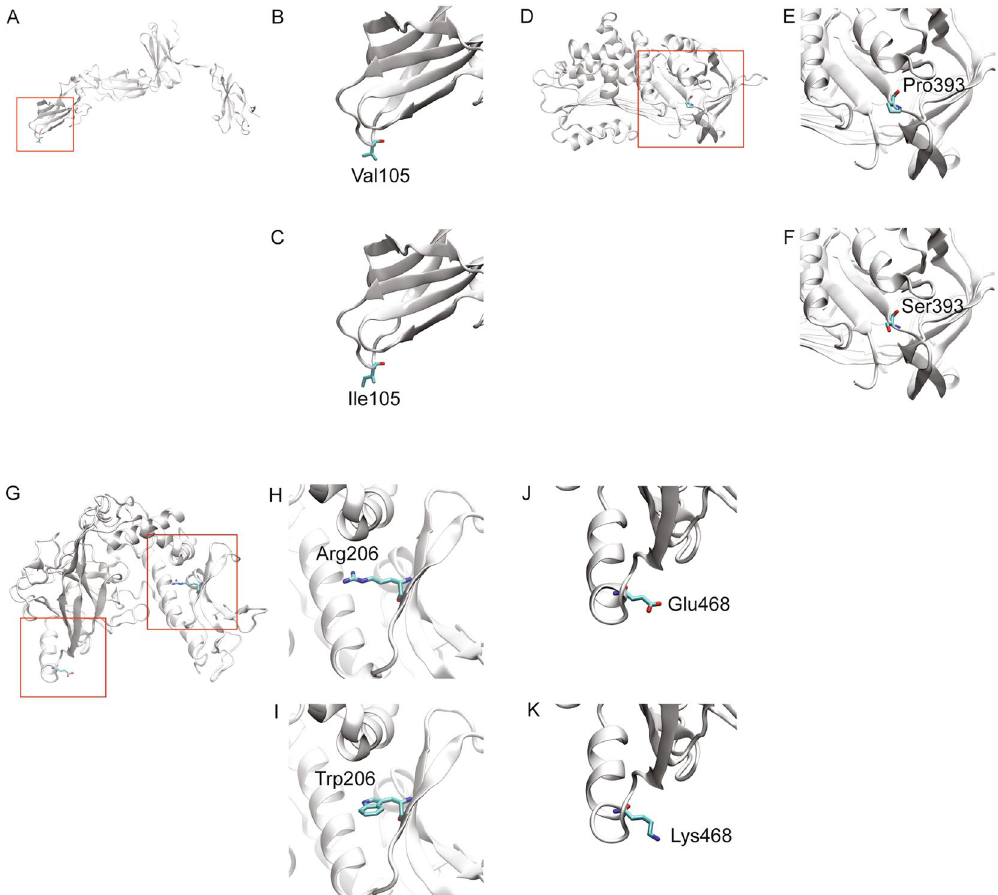
Figure 3. Structural models of wild type and variant proteins. The protein structure is shown in white cartoon representation and the amino acid is shown in stick representation. The red boxed region in each case is enlarged in the subsequent images. ( A ) Structure of CSF2RB with ( B ) wild type Val105 and ( C ) variant Ile105. ( D ) Structure of SERPINA1 with ( E ) wild type Pro393 and ( F ) variant Ser393. ( G ) Structure of SCNN1B with ( H ) wild type Arg206, ( I ) variant Trp206, ( J ) wild type Glu468 and ( K ) variant